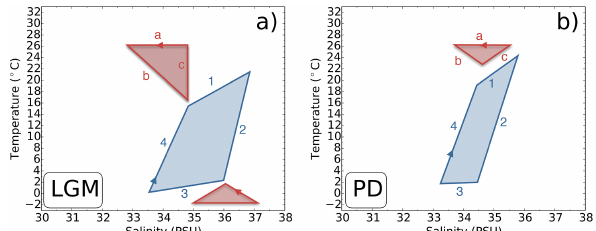
Figure 7. Schematic illustration of the water cycle in the various thermohaline